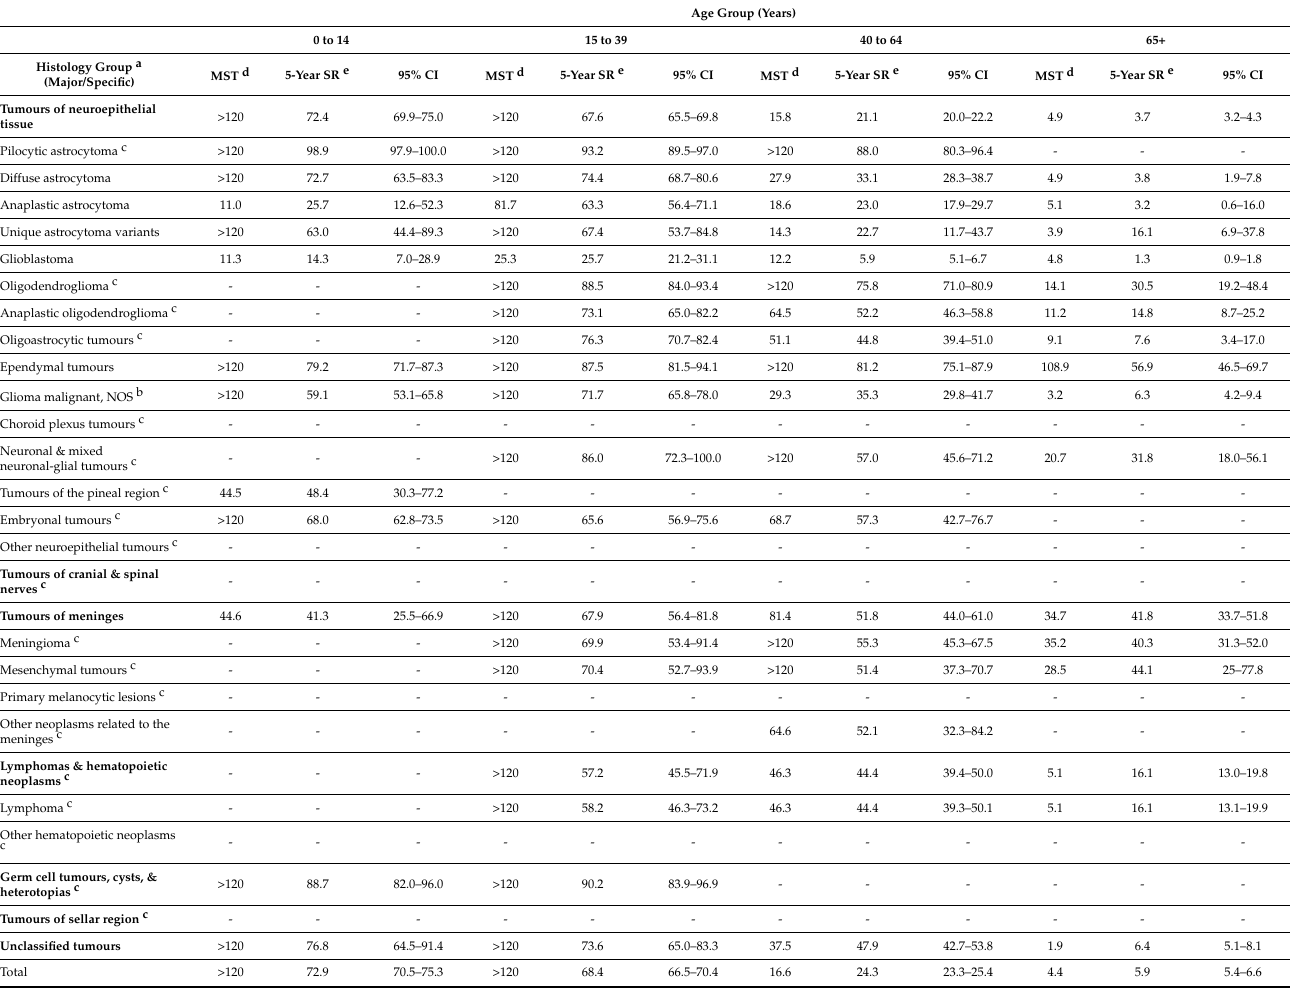
Table 3. Median survival times (MSTs), five-year survival rates (5-year SRs), and associated 95% confidence intervals (CIs) for patients with primary malignant CNS tumours diagnosed between 2010–2017 in Canada (excluding Quebec) by histology and age